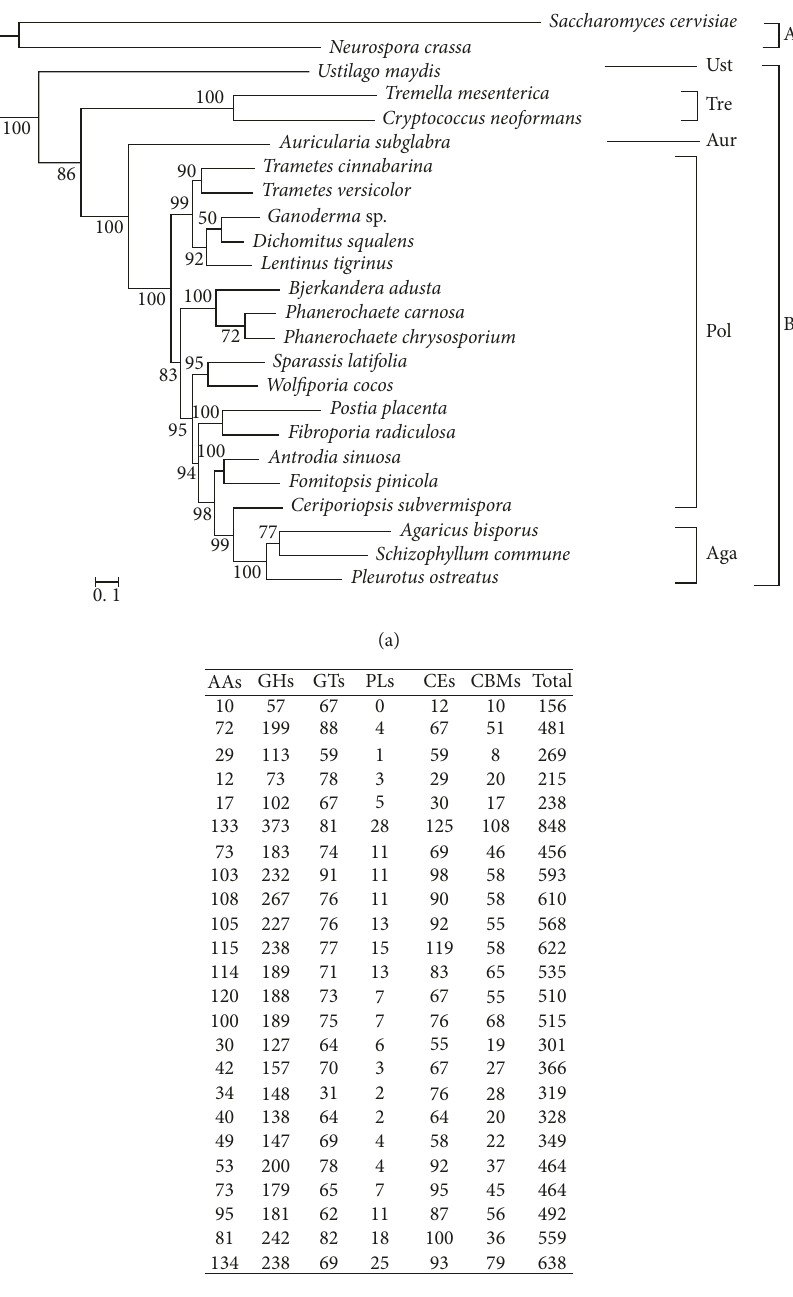
Figure 5: Phylogenetic tree and CAZymes analysis of S. latifolia and a few selected fungal species. (a) The topology of the phylogenetic tree. Saccharomyces cerevisiae and Neurospora crassa are selected as an out-group. Ust, Ustilaginales; Tre, Tremellales; Aur, Auric- ulariales; Pol, Polyporales; Aga, Agaricales; Asc, Ascomycota; Bas, Basidiomycota. (b) CAZymes number of S. latifolia with those of other